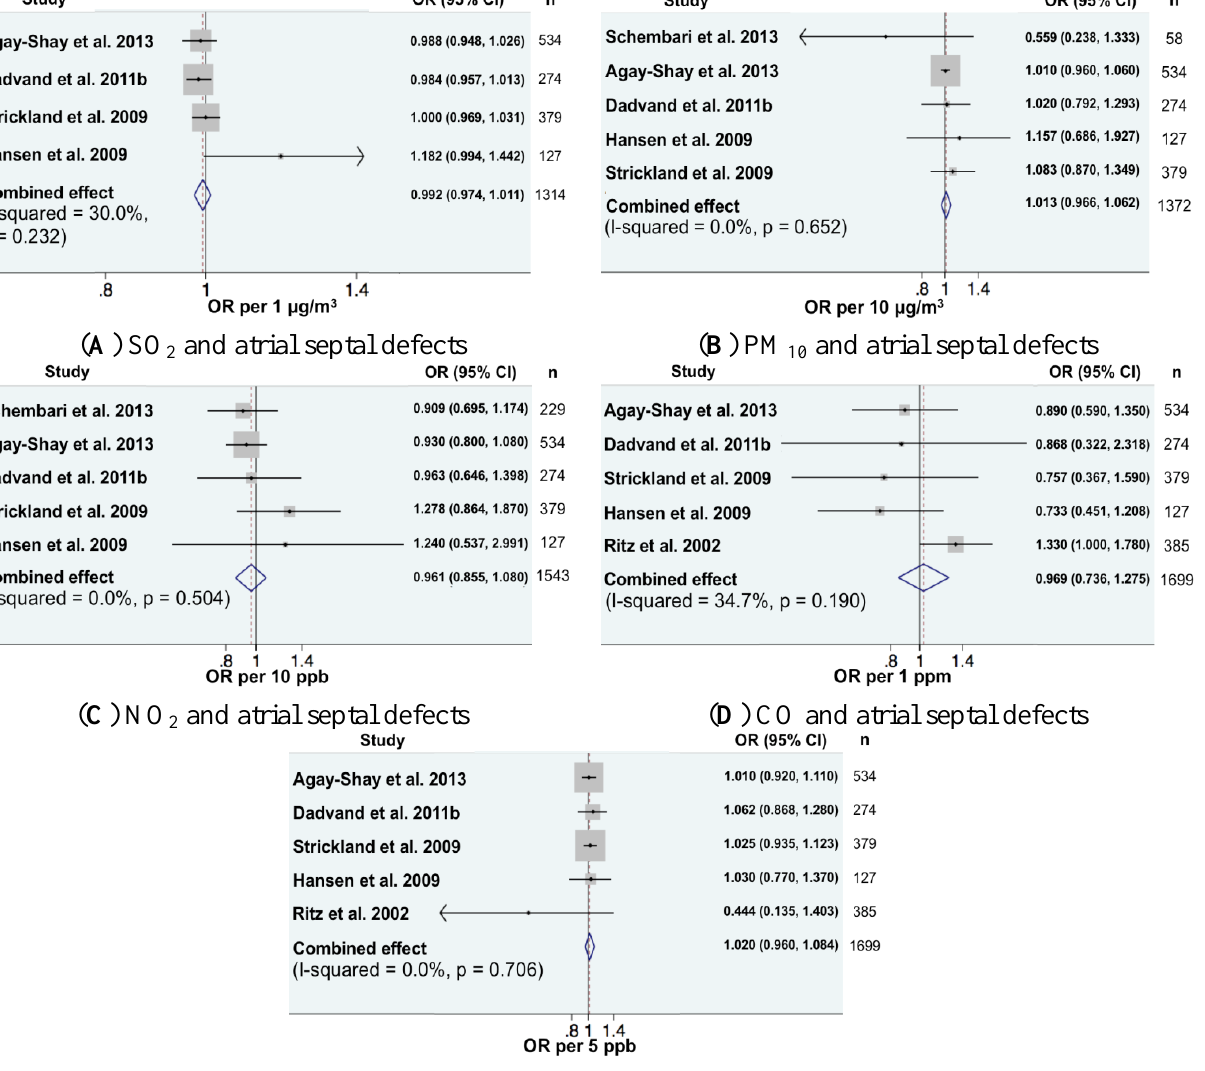
; ( B ) PM ; ( C ) NO ; ( D ) CO and ( E ) O 2 10 2 3